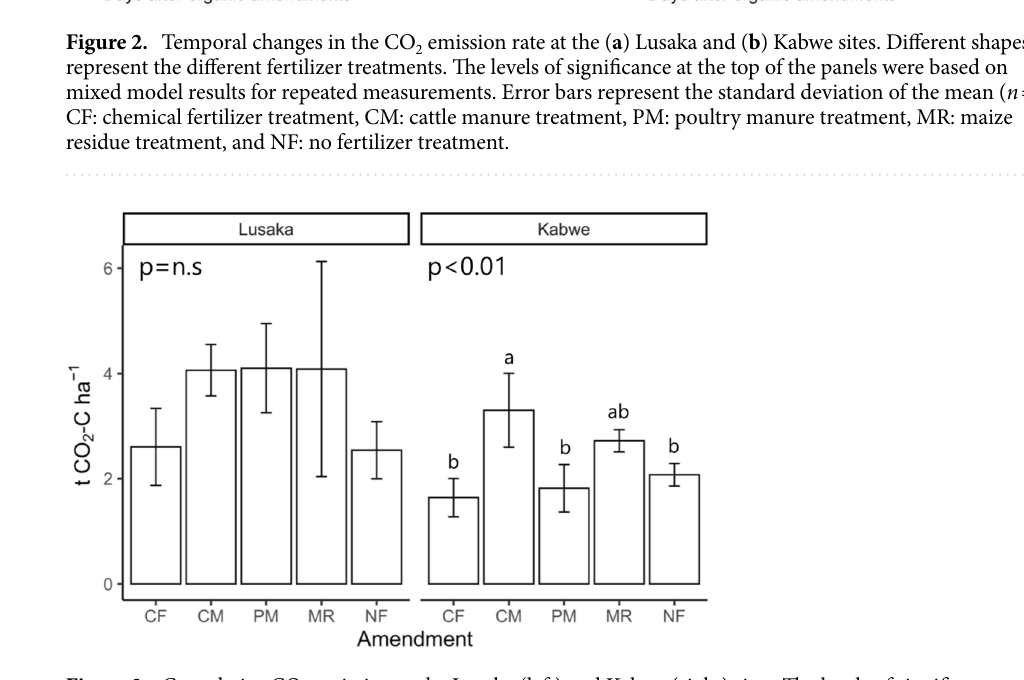
Figure 3. Cumulative CO 2 emission at the Lusaka (left) and Kabwe (right) sites. The levels of significance at the top of the panels were determined using one-way ANOVA, followed by Tukey’s test. Different letters on bars represent significant differences among the treatment means within the same site. Error bars represent the standard deviation of the mean ( n = 3). CF: chemical fertilizer treatment, CM: cattle manure treatment, PM: poultry manure treatment, MR: maize residue treatment, and NF: no fertilizer